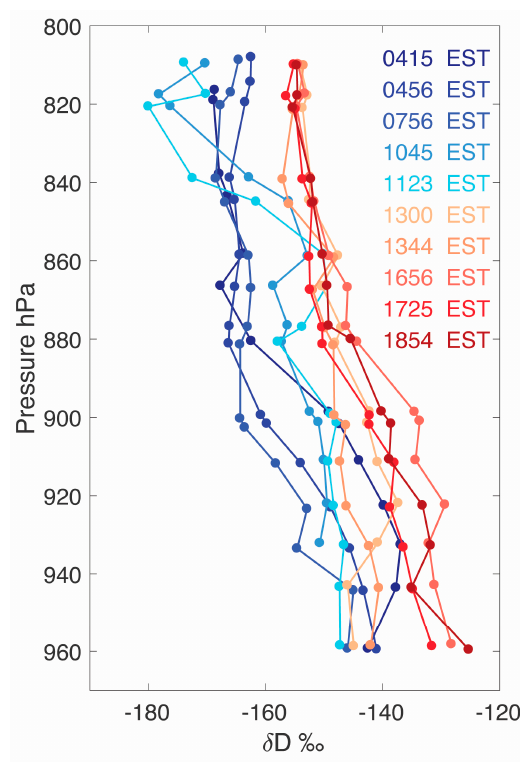
Figure 6. δ D vertical profiles sampled while driving an isotopic analyzer along the Auto Road on 19 August 2016. Profiles are color-coded by time. All times mark the start of the profile, which took 30–60 min to complete.